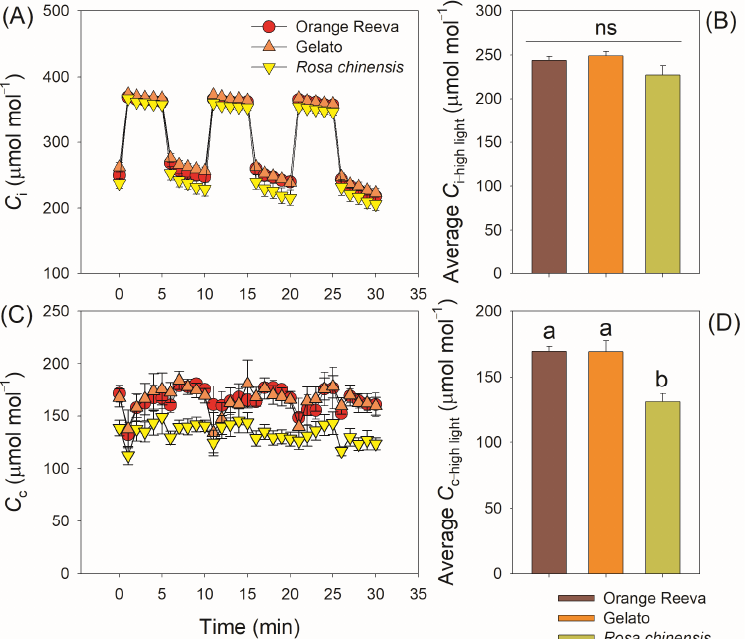
Figure 6. Dynamic changes and average values of intercellular CO 2 concentration ( C i ) ( A , B ) and chloroplast CO 2 concentration ( C c ) ( C , D ) under fluctuating light in two modern rose cultivars (Orange Reeva and Gelato) and the old Chinese rose plant Rosa chinensis . Adapted leaves were exposed to four repeated cycles of 100 and 1500 μ mol photons m − 2 s − 1 (every 5 min). Data are means ± SE ( n = 5).